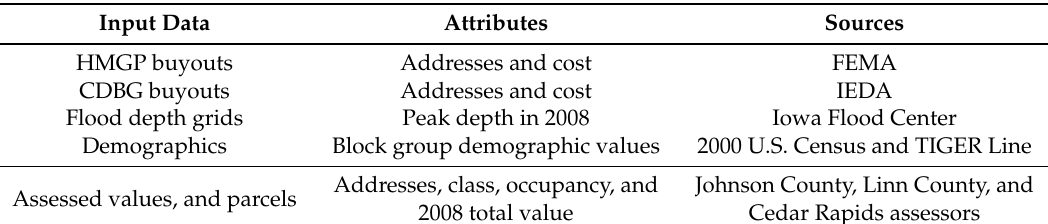
Table 3. Input geospatial data.